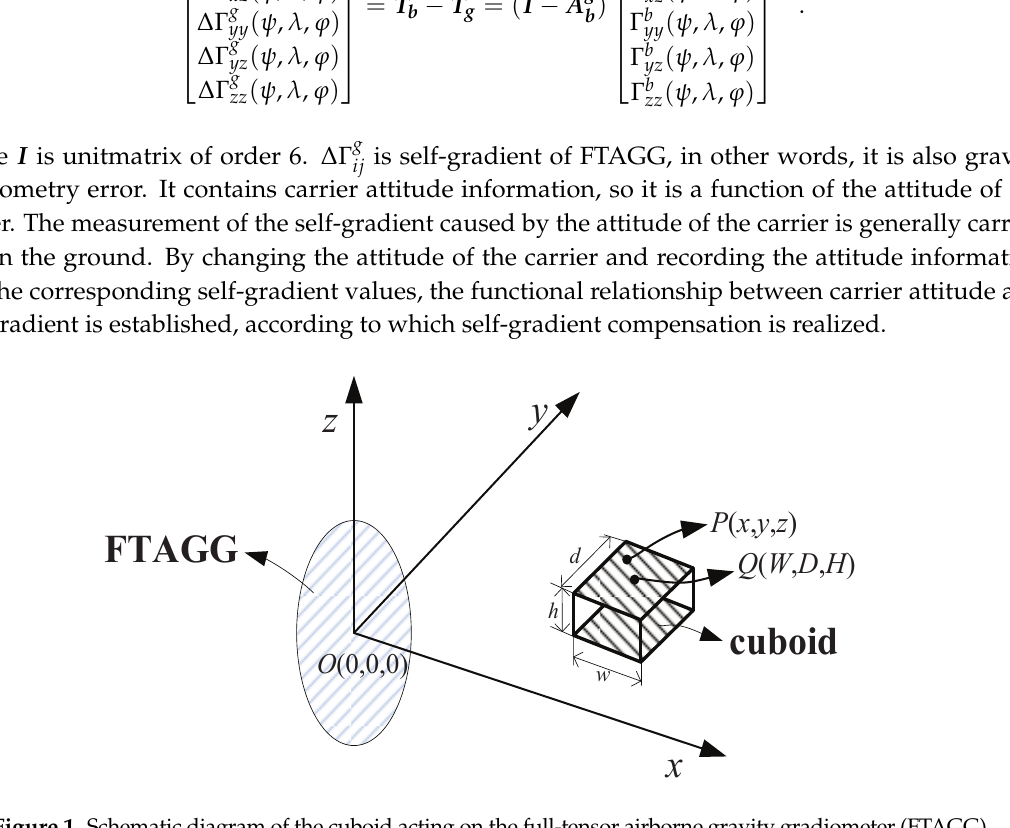
Figure 1. Schematic diagram of the cuboid acting on the full-tensor airborne gravity gradiometer